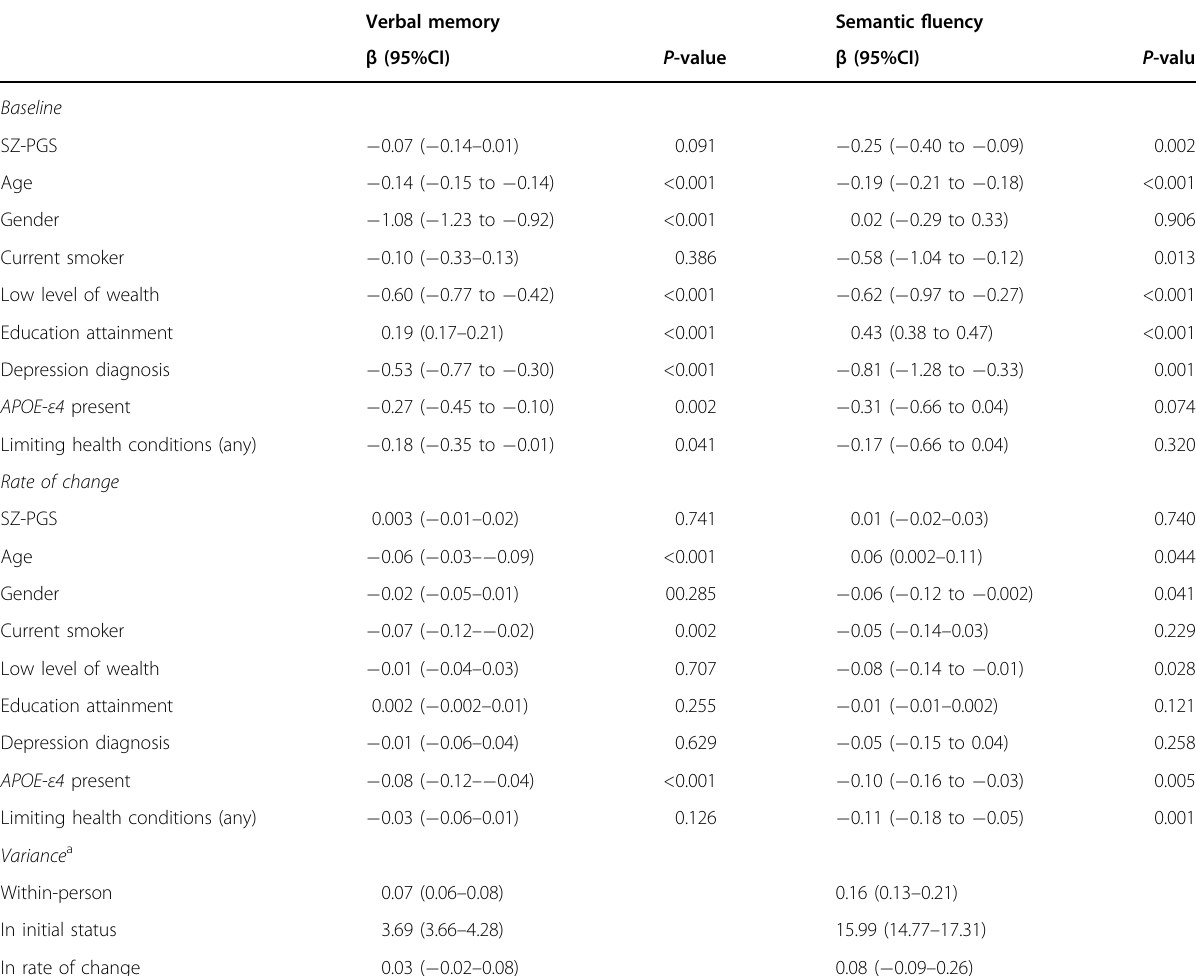
Table 2 Associations between schizophrenia polygenic score (SZ-PGS) and cognitive function in older adults over the 10-year